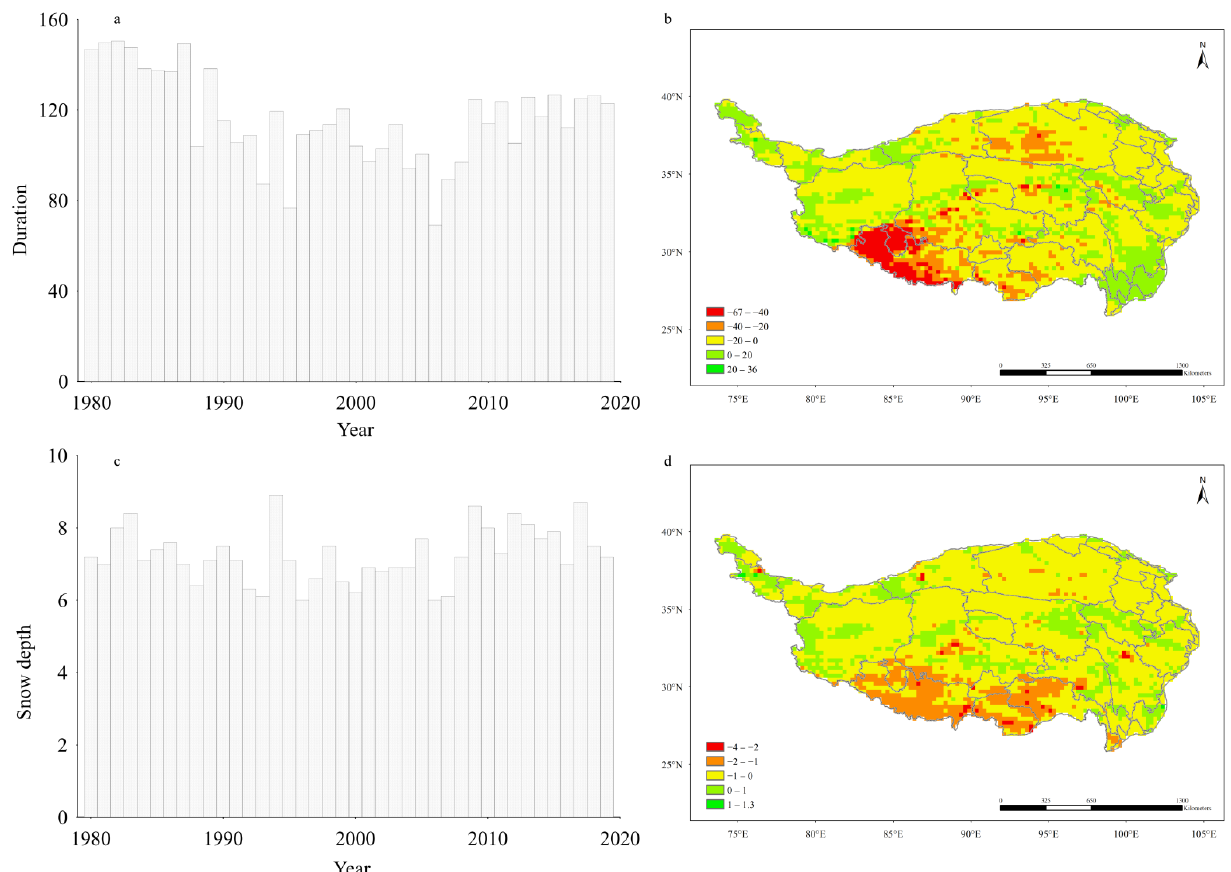
Figure 3. The regional average variation sequences and the spatial distribution of long-term variations of the duration of snow disasters and snow depth (( a , b ) represent the duration of snow disasters; ( c , d ) represent the snow depth, respectively).